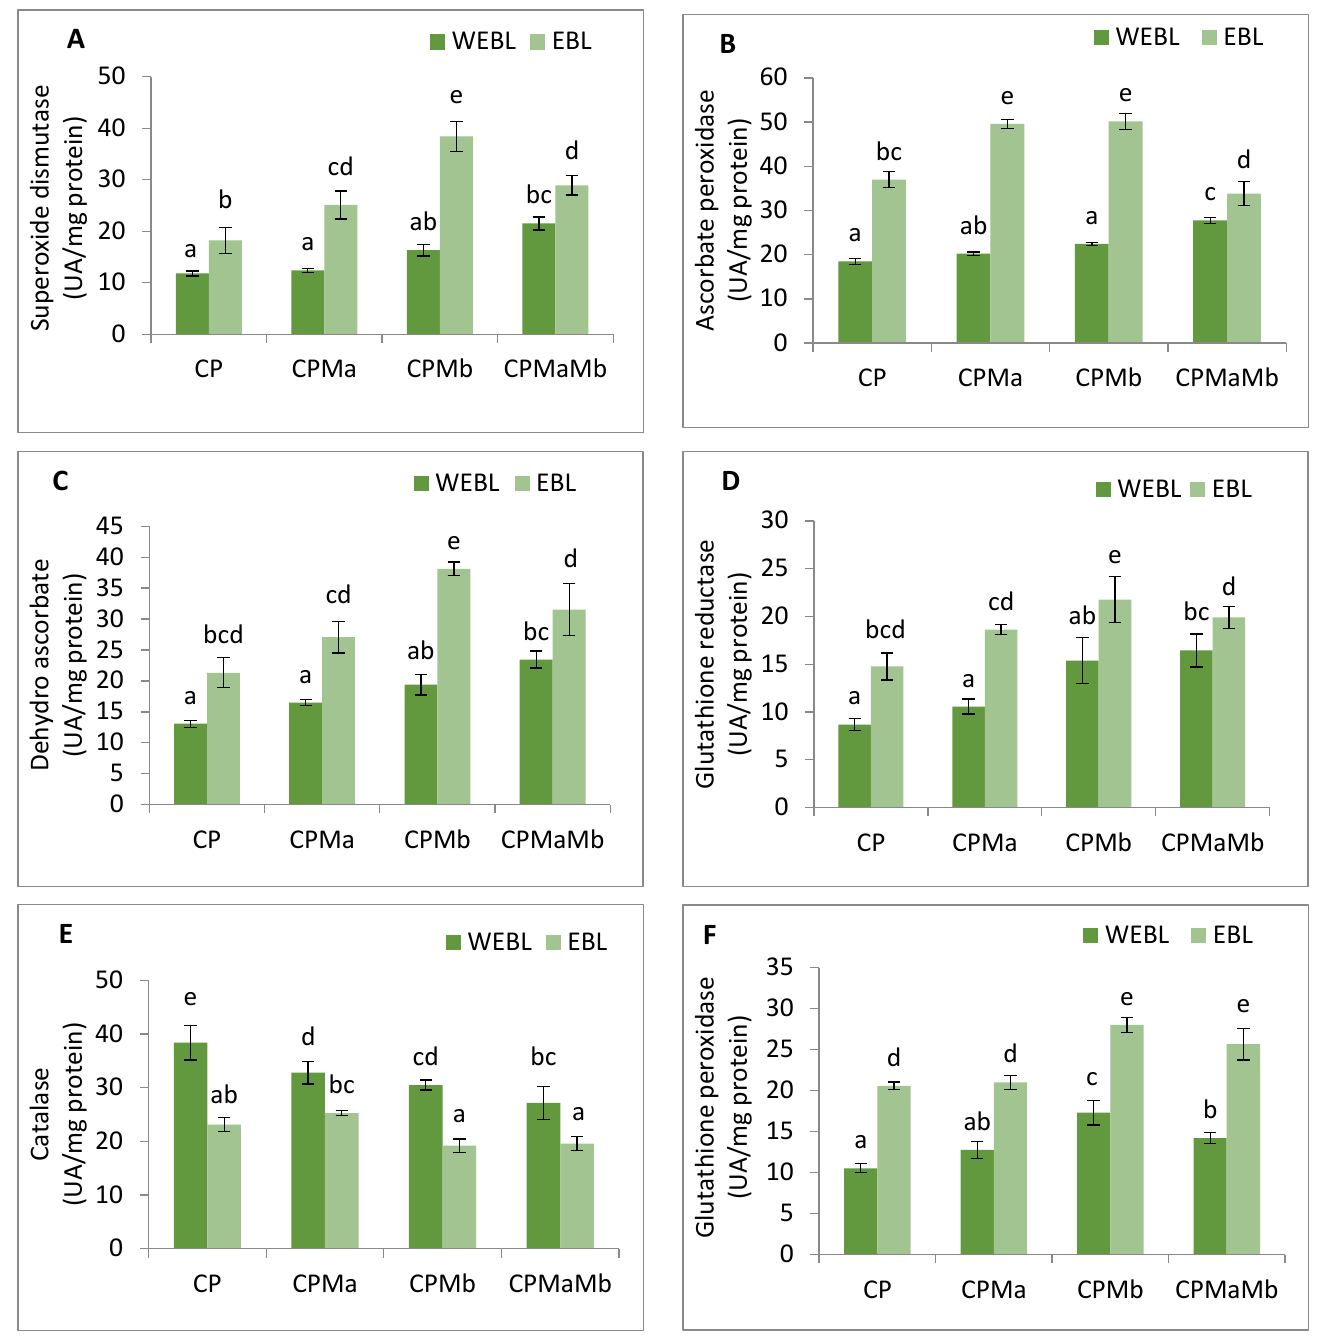
Figure 4. Effect of seed priming with 100 nM of 24-epibrassinolide (EBL) and plant-growth-promoting rhizobacteria ( Pseudomonas aeruginosa (Ma, 10 9 cells/mL) and Burkholderia gladioli (Mb, 10 9 cells/mL)) on the activity of ( A ) SOD, ( B ) APOX, ( C ) DHAR, ( D ) GR, ( E ) CAT and ( F ) GPOX of 10-day-old B. juncea L. seedlings under chlorpyrifos (CP) toxicity. Data are presented as mean of three replicates ± s.d. (standard deviation). Means were compared using two-way analysis of variance followed by Tukey’s post-hoc test ( p < 0.05). Different superscripts indicate significant difference between the treatments. (Note: WEBL = without 24-epibrassinolide , EBL = 24-epibrassinolide